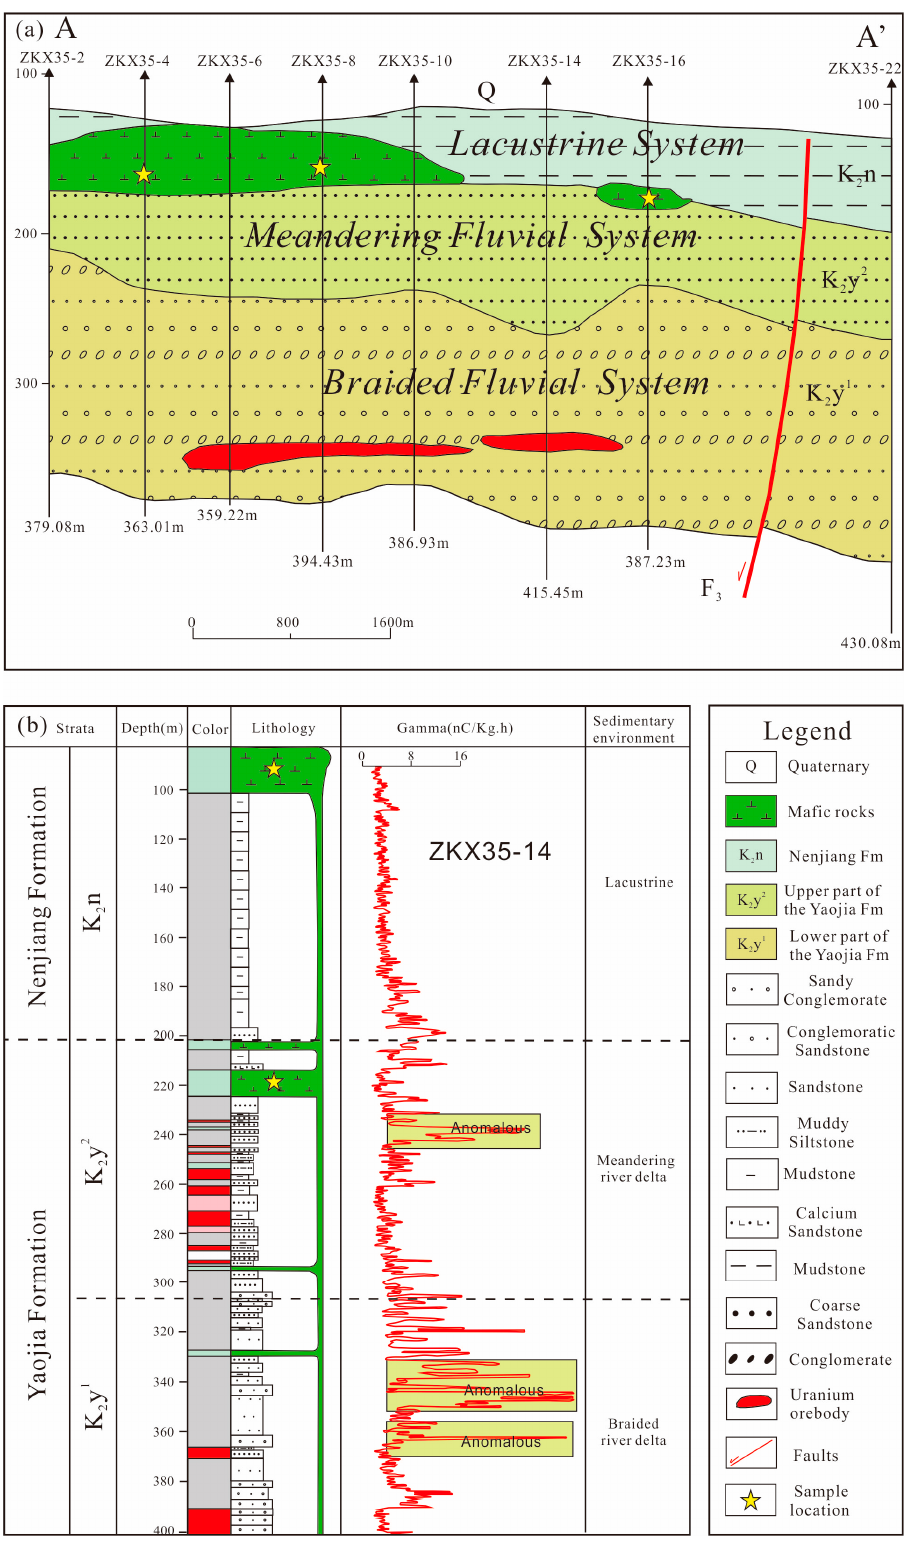
Figure 2. Geological cross-section ( a ) and lithological column of drill hole ZKX35-14 ( b ) in the Qianjiadian uranium deposit showing the relationship between diabase, faults, and uranium mineralization (the location is shown in Figure 1b).